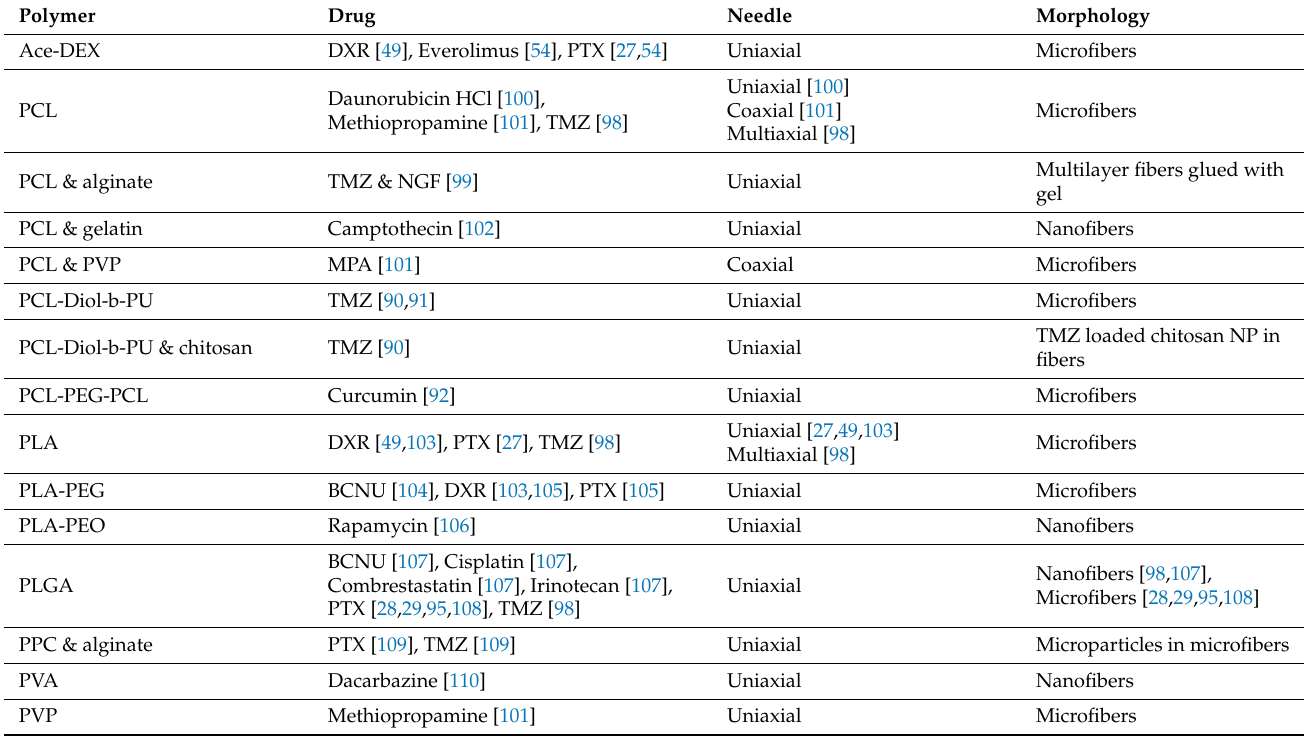
Table 2. Drug delivery devices formulated via electrospinning. Details the polymeric material, drug encapsulated, needle setup, and final